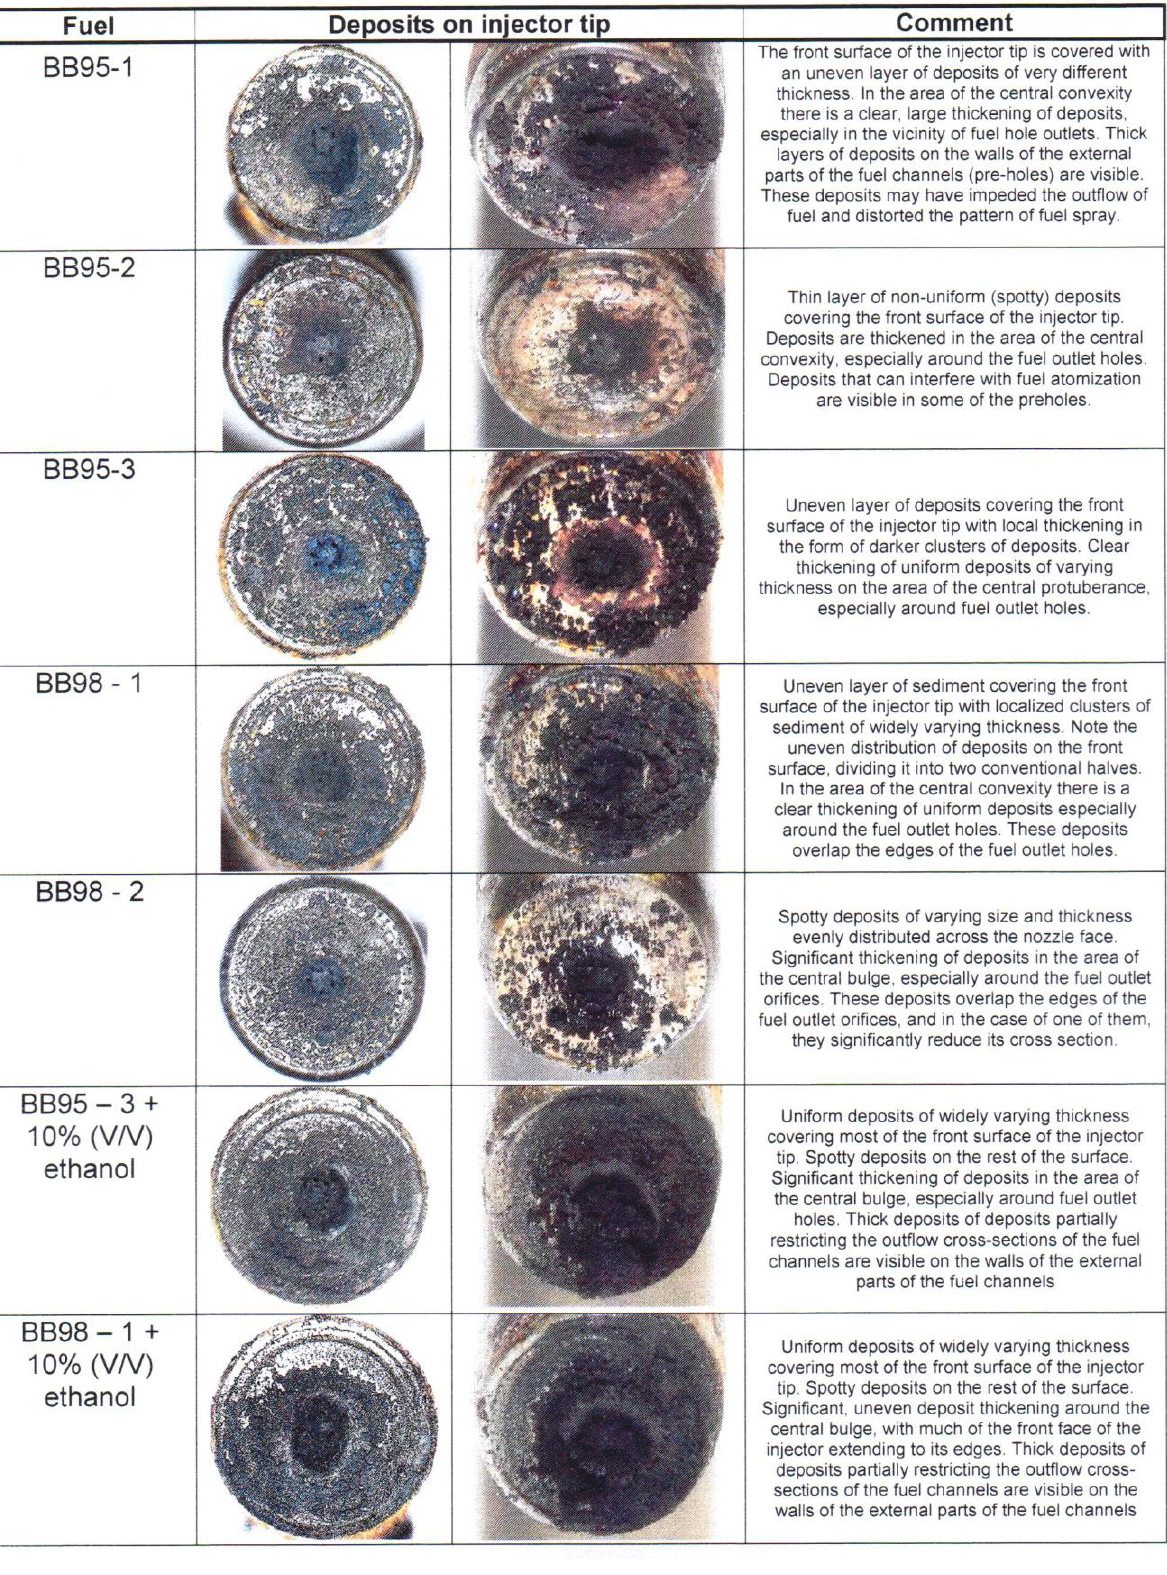
Table 3. Deposits on representative injectors for each of the fuel tests